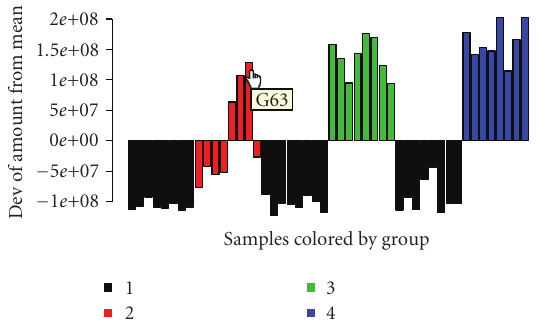
Figure 2: Examples for output generated by meta P- server : metabo- lite barplot colored by the phenotype “groups” with the classes 1–4.